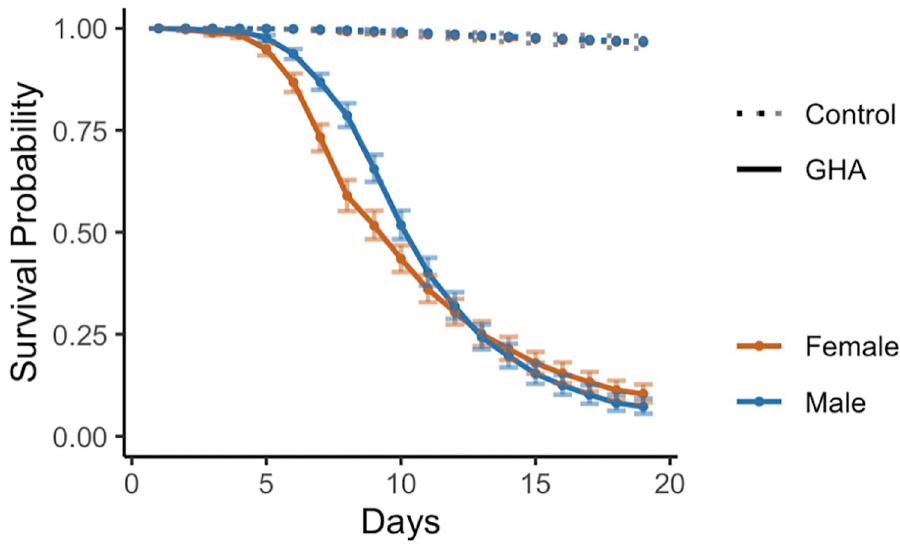
Fig 3. Sexual dimorphism in survival of D . melanogaster after inoculation with B . bassiana strain GHA (Experiment 2). Inoculated males (blue) survived better than inoculated females (orange) until day 12 post spray. See S5 Table for statistical analysis. This figure shows model estimates with 95% Bootstrap confidence intervals from the raw data shown in S7 Table.